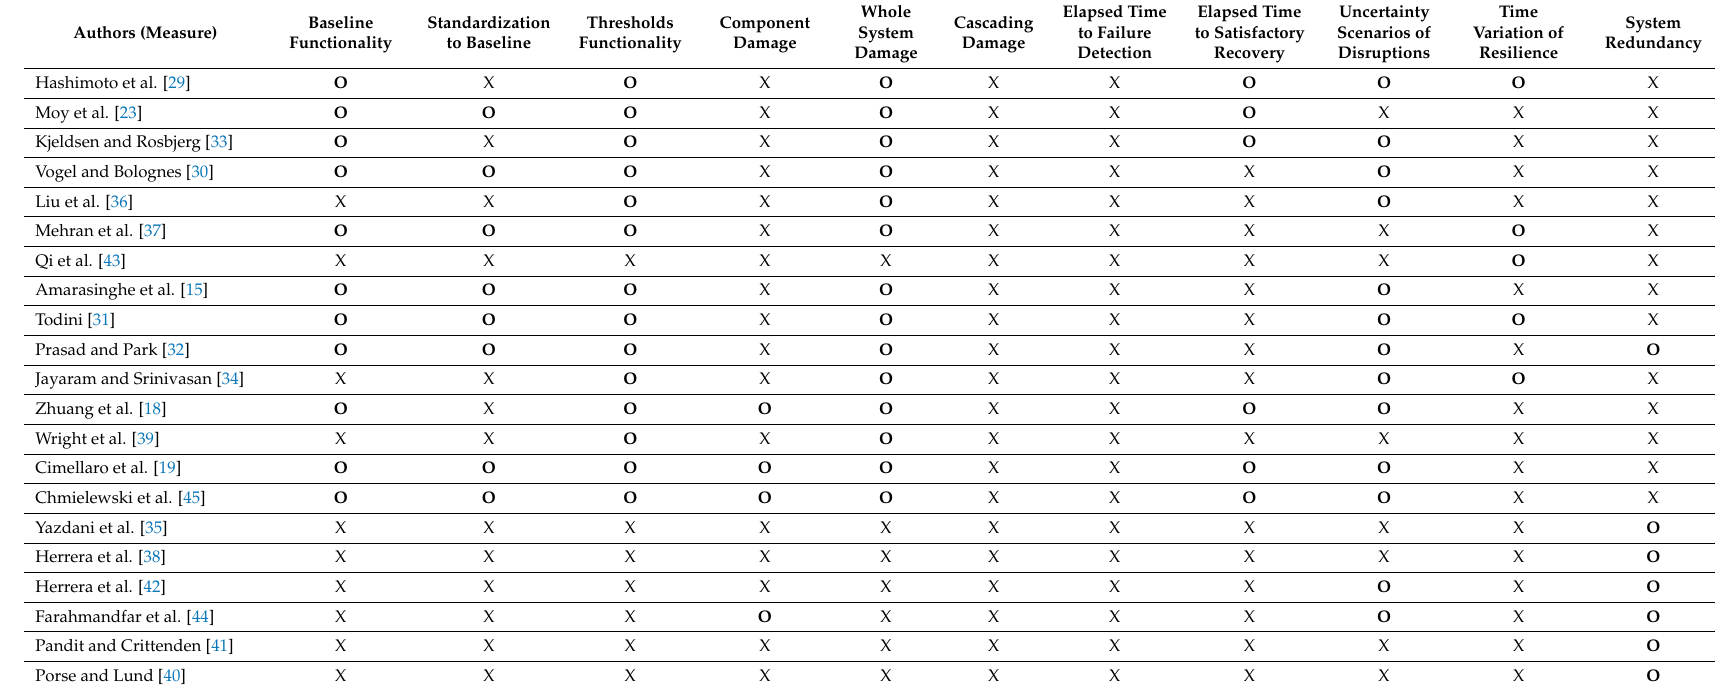
Table 5. Evaluation across the selected measures against review